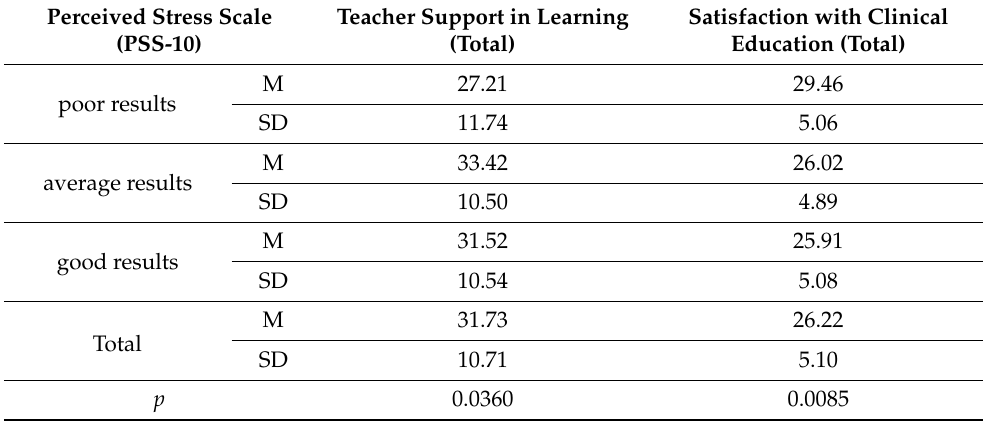
Table 3. The scale of perceived stress and the assessment of teacher support and satisfaction with clinical